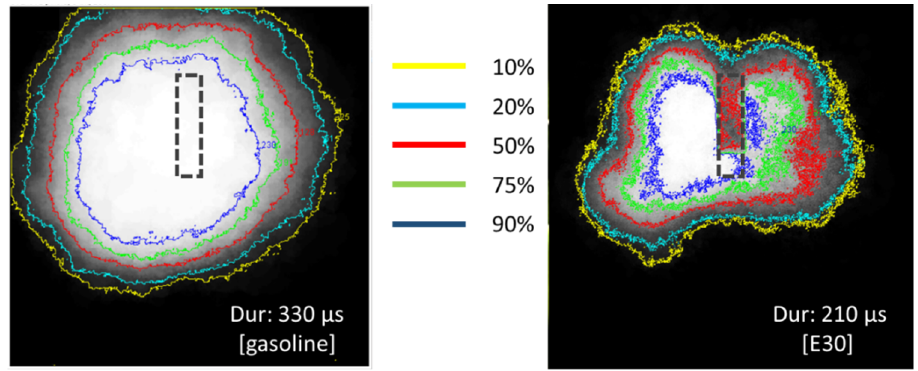
Figure 20. Flame variability at 6 CAD after ST in PFS conditions, the grey dotted lines indicate the spark plug position.